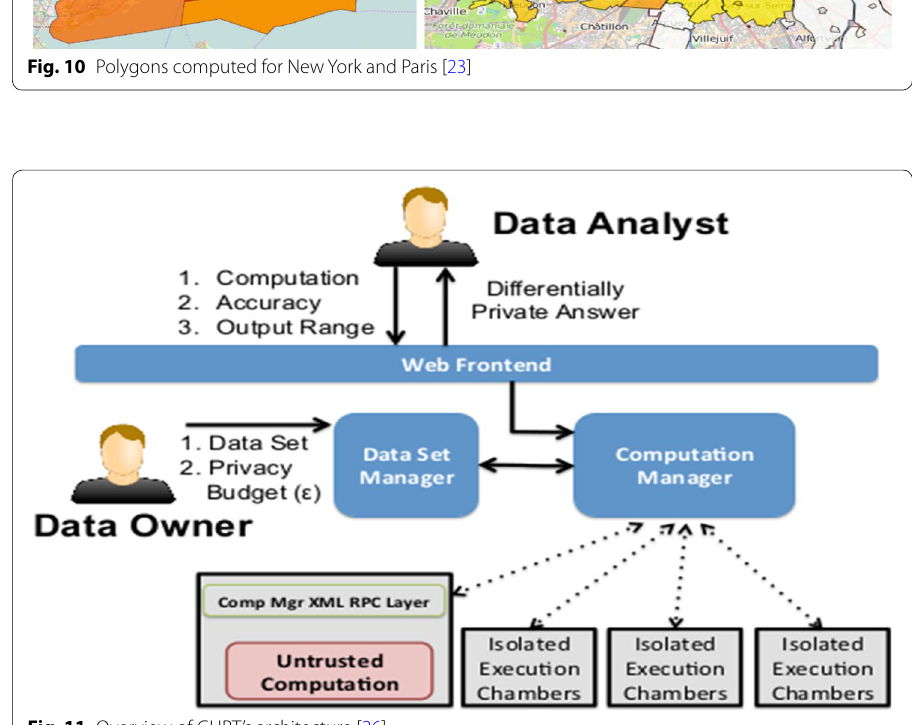
Fig. 11 Overview of GUPT’s architecture